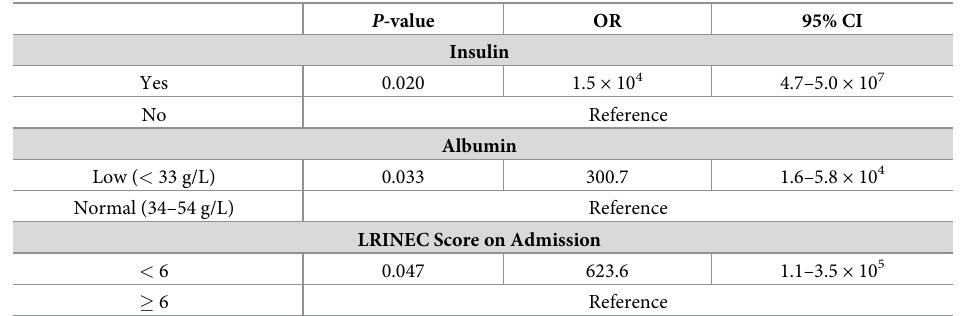
Table 5. Multivariant analysis for factors associated with progression to major LEA.